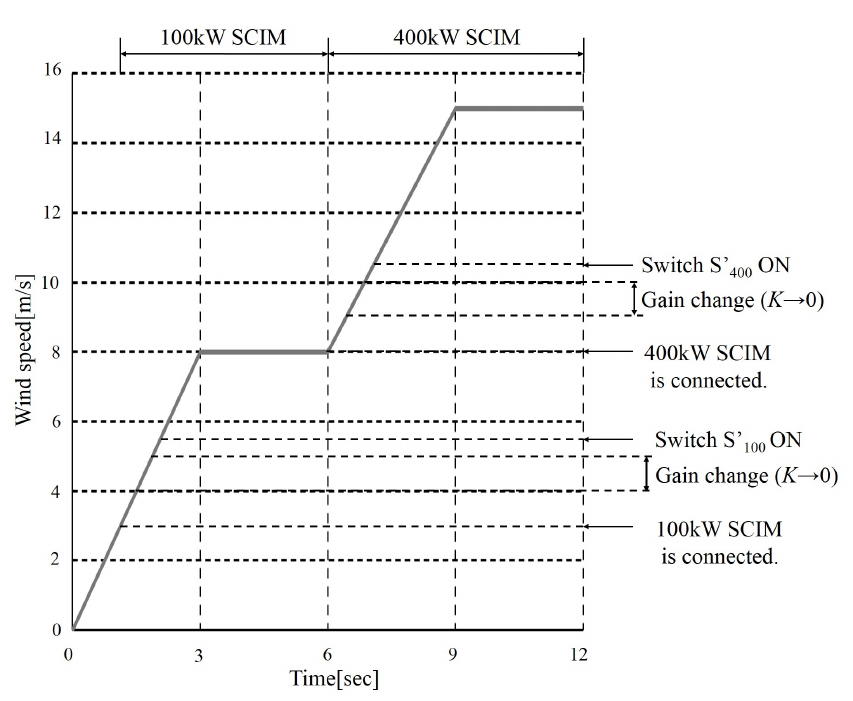
Figure 3. Simulation condition by the wind